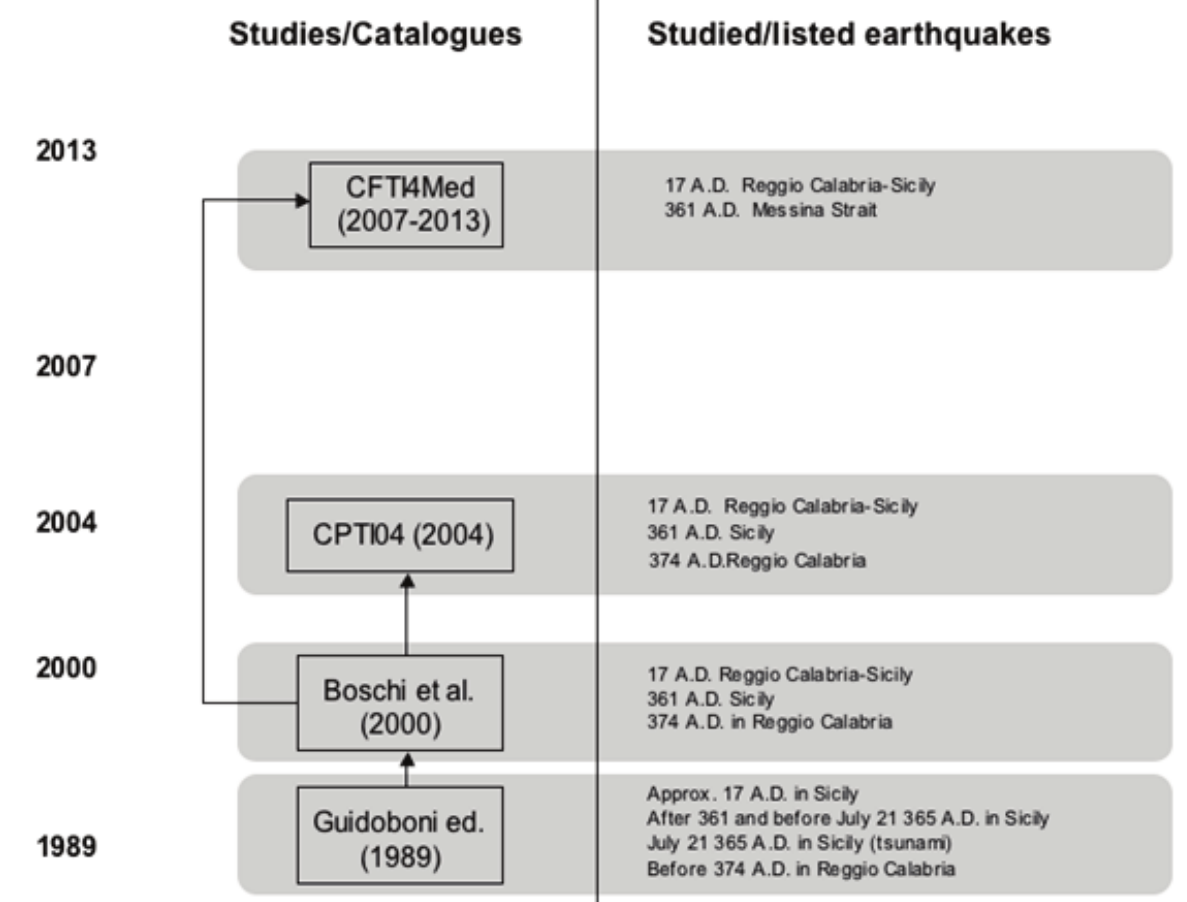
Figure 3. Recent studies and catalogues that deal with earthquakes in the period considered in this